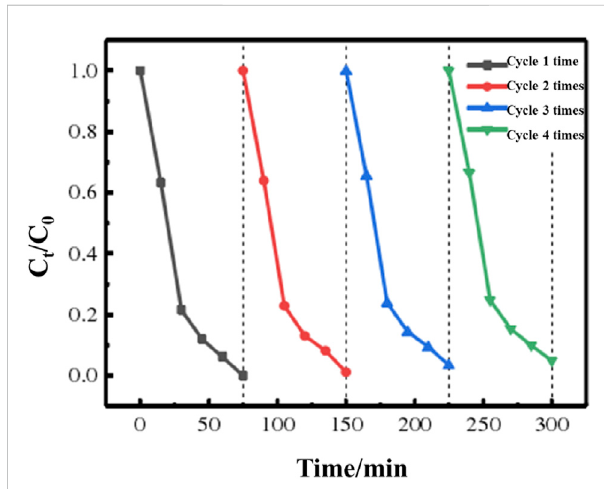
FIGURE 11 Cyclic stability graph of 3:1 g-C 3 N 4 /MeTMC-COP degraded RhB under visible light.